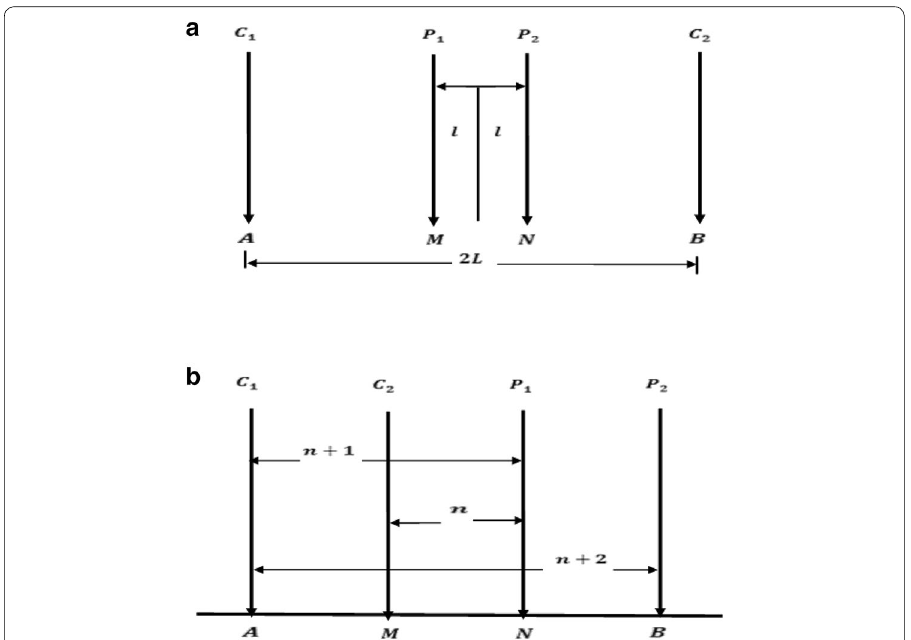
Fig. 4 a Typical Schlumberger electrode configuration, b Dipole–Dipole electrode configuration (After